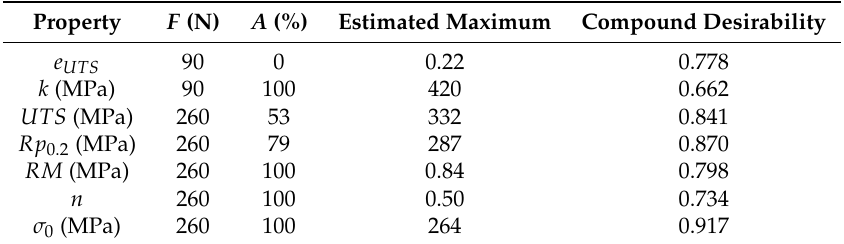
Table 6. Estimated maximum obtained from a quadratic response